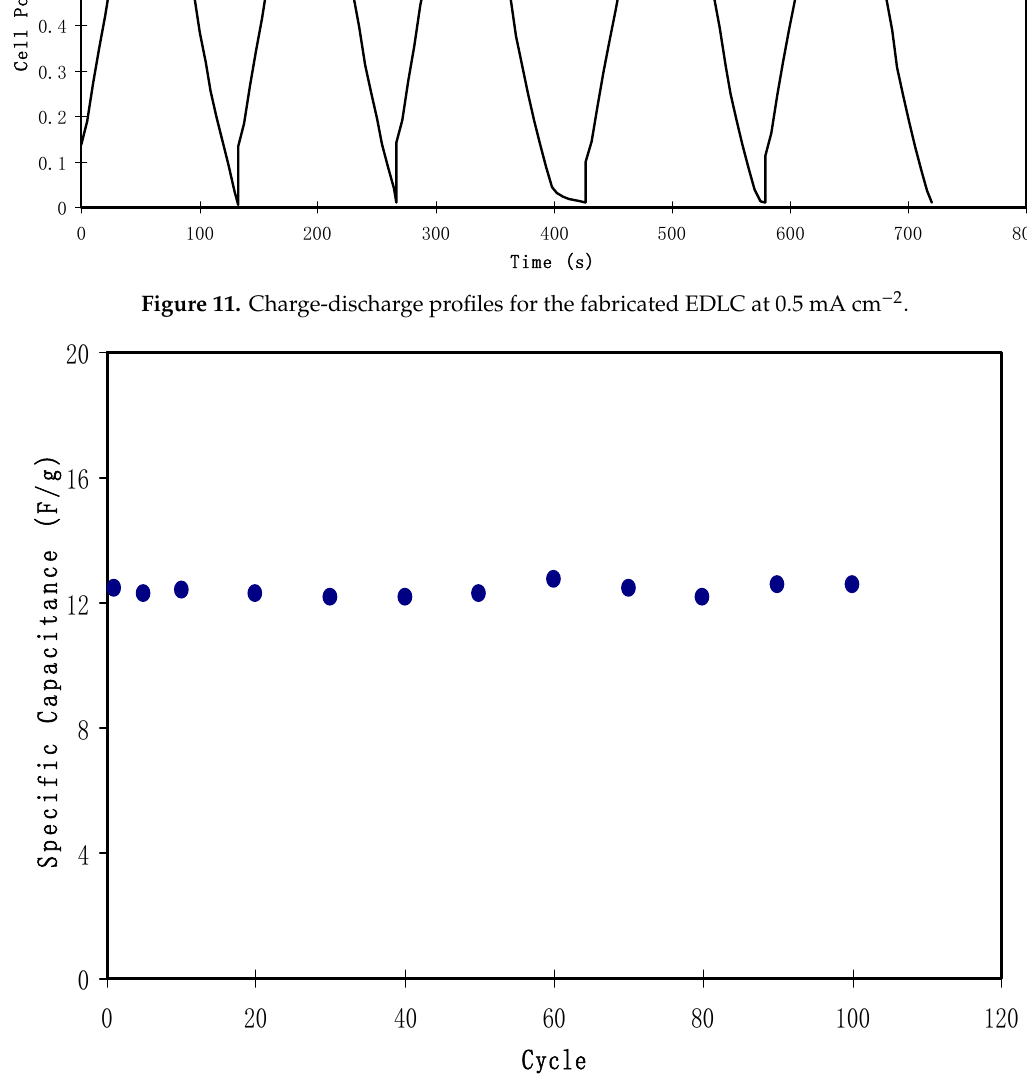
Figure 12. Specific capacitance of the fabricated EDLC for 100 cycles.